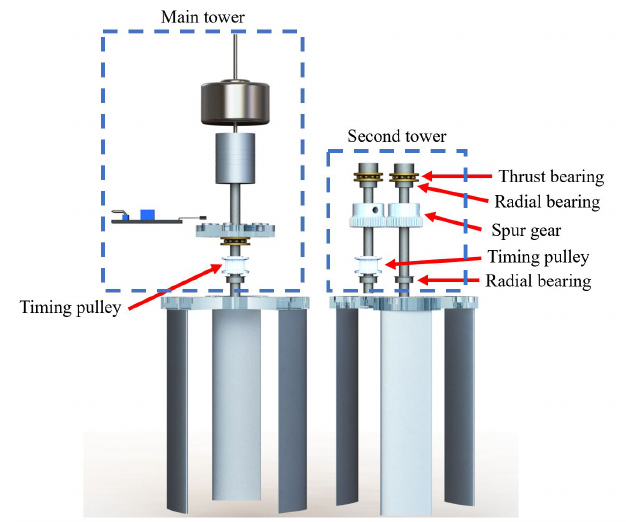
Figure 2. Critical mechanical components of the counter-rotating and overlapping tower